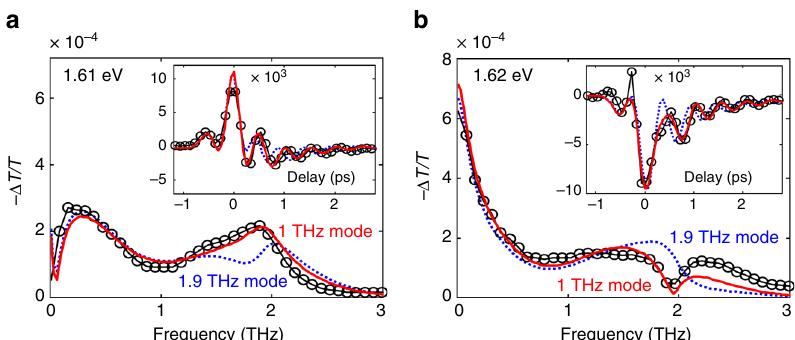
Fig. 3 Quantitative interpretation of the experiment via the 3rd order nonlinear polarization model. Comparison of the 3rd order nonlinear polarization model describing phonon driven optical band gap modulation ( red solid curve ) with the experimental data ( black circles ) in the frequency domain at the probe frequency of a 1.61 and b 1.62 eV, respectively. Resonant excitation of 1 THz mode describes the oscillatory behavior very well, whereas the other possibility, non-resonant excitation of 1.9 THz mode shows a 90° phase shift ( blue dashed curve ) for both energies. Inset : Same comparison in the time domain. See SI for detailed explanation of the